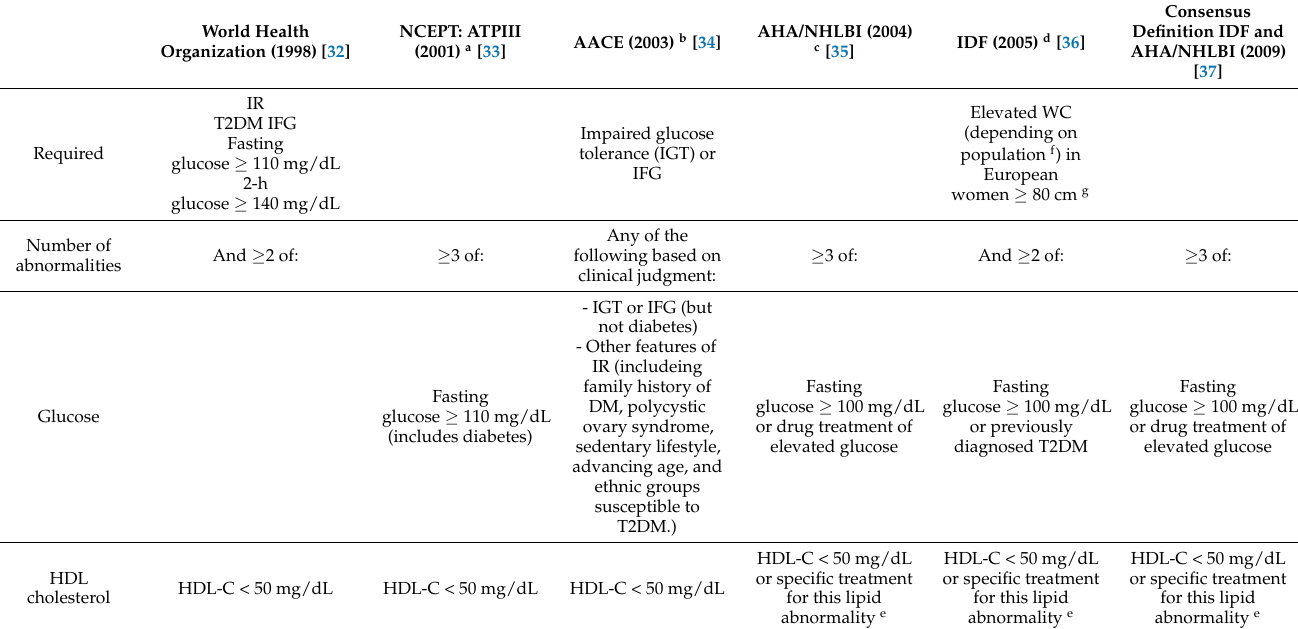
Table 1. Diagnosis of MetS [7] .